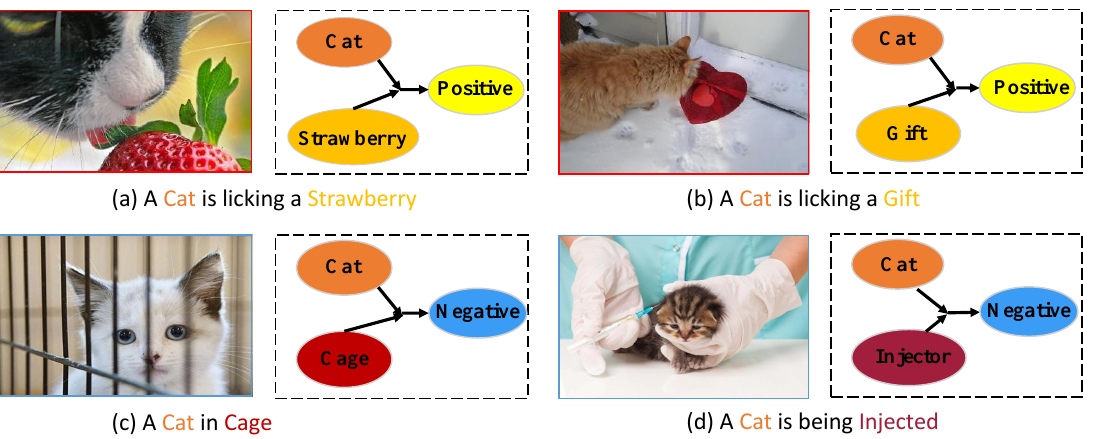
Figure 1. Examples from EmotionROI dataset and social media: We use a graph model to describe the sentimental interaction between objects and the double arrow means the interaction in the process of human emotion